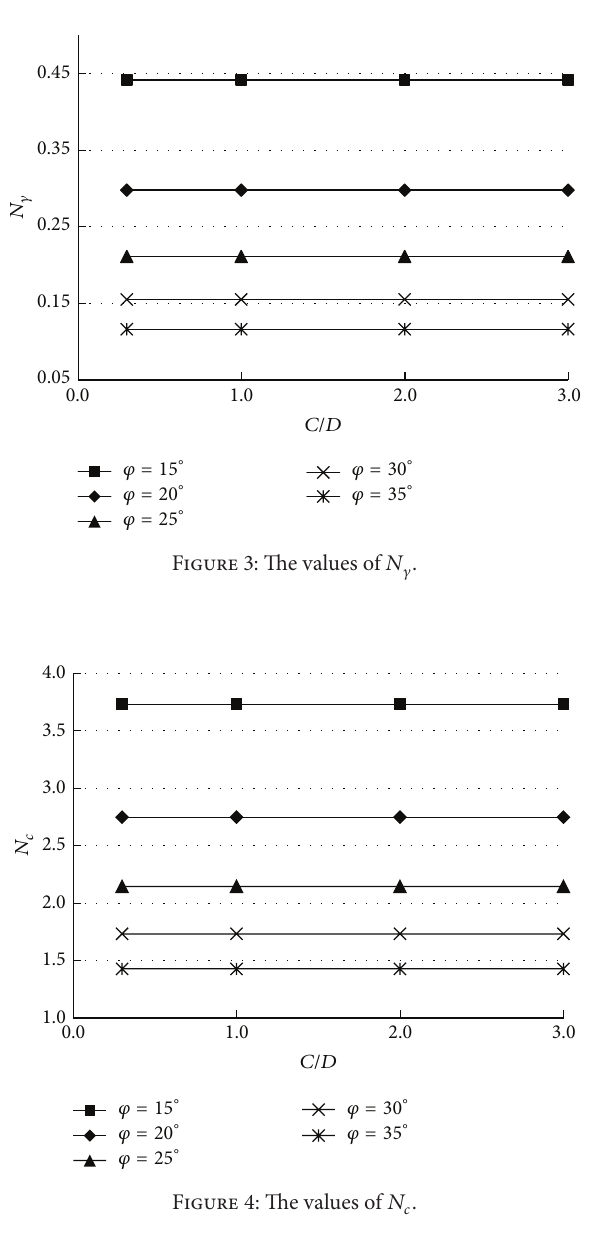
Figure 4: The values of 𝑁 𝑐 .